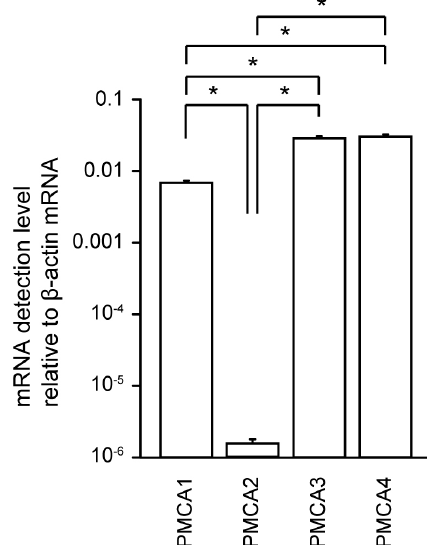
Figure 1. mRNA levels of plasma membrane Ca 2+ –ATPase (PMCA)1–4 in human odontoblast cell lines (HBO cells). Real-time RT-PCR was used to quantify the detection level of PCMA1–4 mRNAs by measuring the increase in fluorescence elicited by the binding of SYBR green dye to double-stranded DNA. Data were analyzed by the 2 − [ ∆∆ Ct] method, with β -actin as an internal control (which was positive in all samples). Each bar denotes the mean ± SE of 7 experiments. Expression levels were normalized to β -actin mRNA levels. Statistically significant differences between columns (shown by solid lines) are marked with asterisks. * P < 0.05.